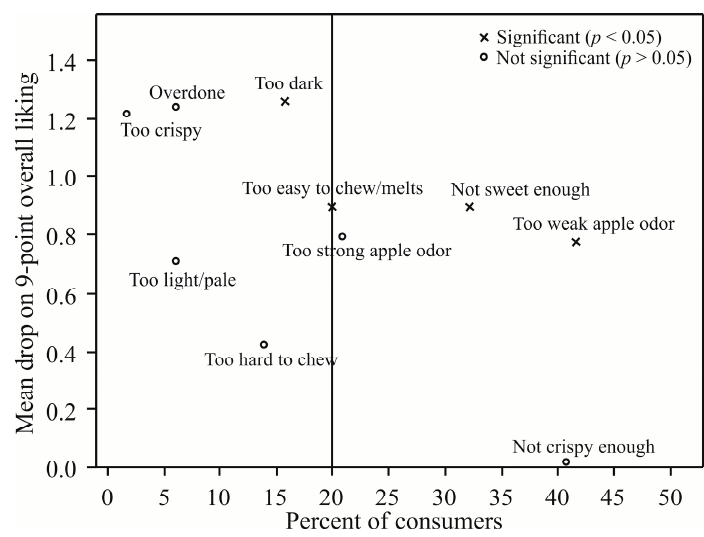
Figure 5. Mean drop analysis for the cookies with 50% of coarse APF ( n = 115 respondents).